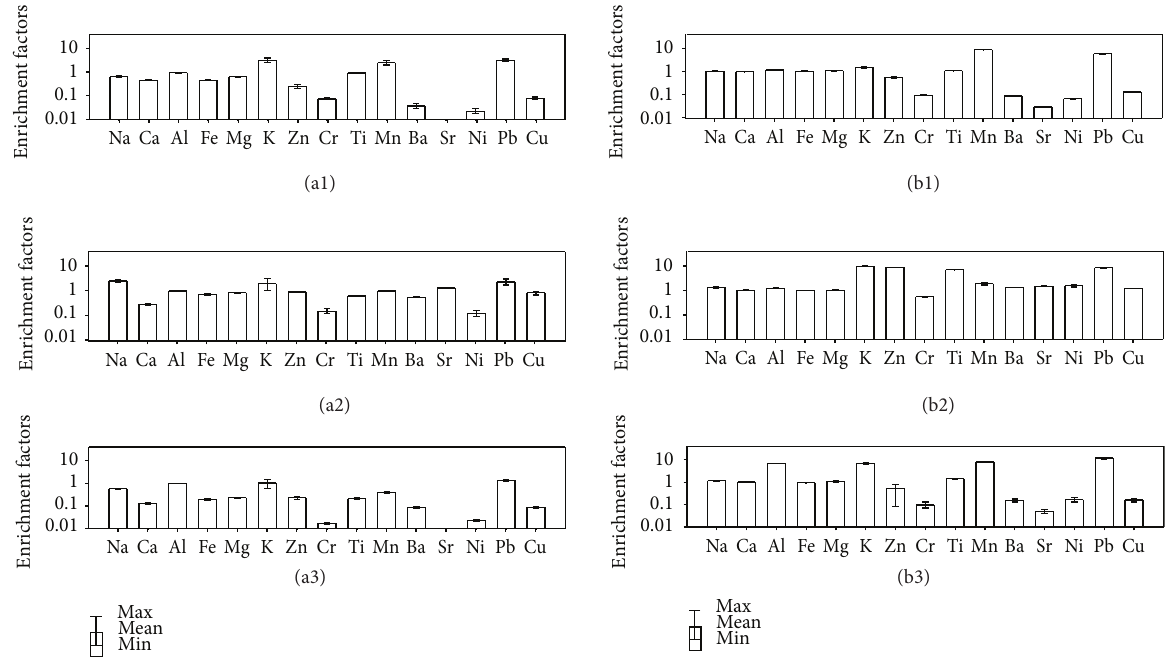
Figure 5: EF values of 15 metals with Al or Fe as reference elements at the Pescadores Islands. For example, (a1) ∼ (a3) are the EF of eastern, central, and western source regions calculated by using aluminum as reference element; (b1) ∼ (b3) are the EF of eastern, central, and western source regions calculated by using iron as reference element.